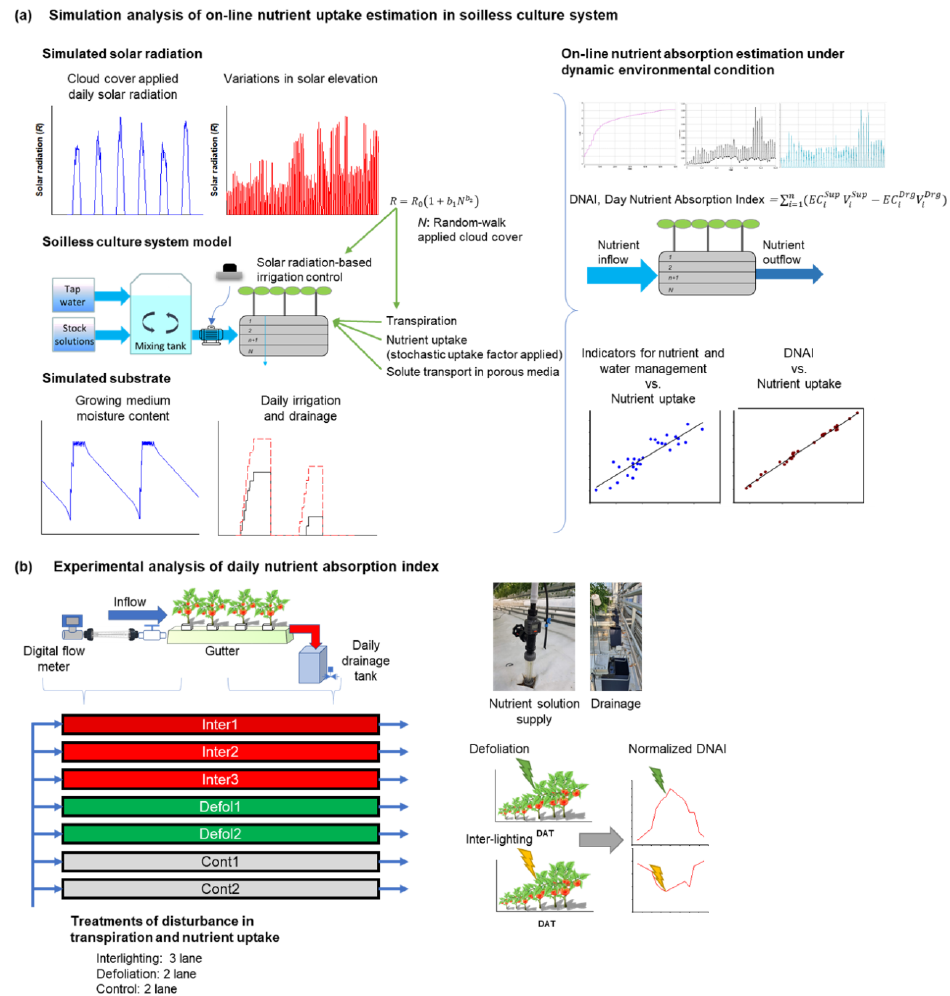
Figure 1. Schematic of simulation and experimental analysis of day nutrient absorption index. ( a ) Simulation analysis of on-line nutrient uptake estimation in soilless culture system. ( b ) Experimental analysis of daily nutrient absorption index